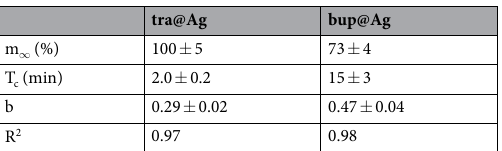
Table3. The kinetic parameters of the release of tramadol and